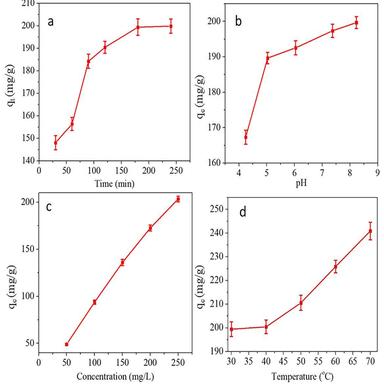
The effects of (a) time (pH 8.5, 20 mL of 200 mg/L MB, 30 ◦C, and 0.02 g FG2I), (b) pH (180 min, 20 mL of 200 mg/L MB, 30 ◦C, and 0.02 g FG2I), (c) concentration of MB (180 min, pH 8.5, 30 ◦C, and 0.02 g FG2I), (d) and temperature (180 min, pH 8.5, 20 mL of 250 mg/L MB, and 0.02 g FG2I) on the adsorption capacity of FG2I.